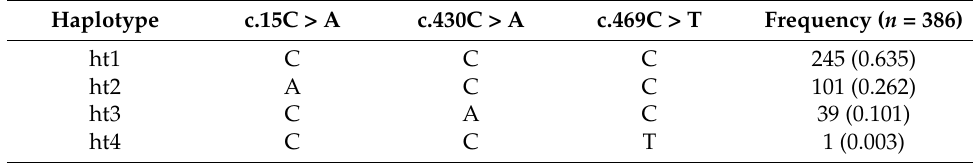
Table 3. Haplotype frequencies of 3 SPRN polymorphisms in cats.